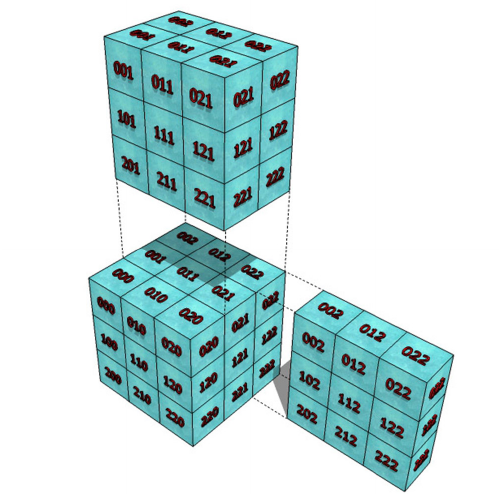
Figure 4. Distribution of the index of Cartesian Hermite coefficients of a second-order voxel.